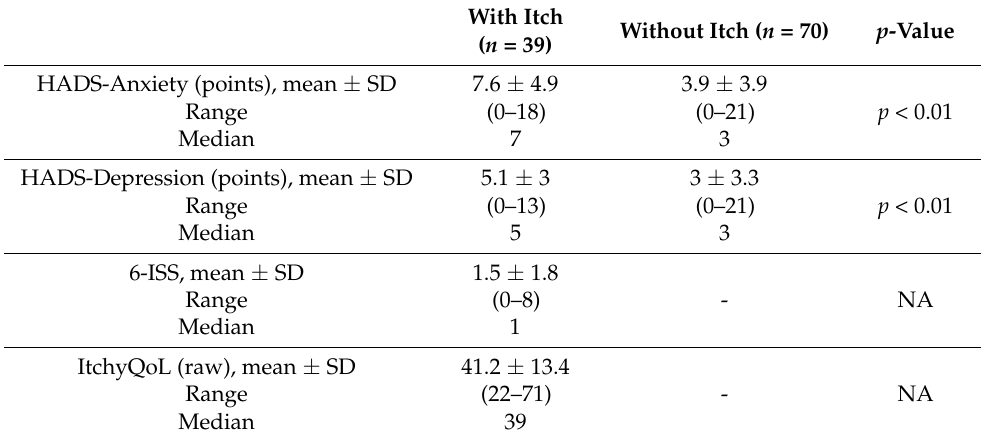
Table 4. Questionnaires’ scores and dependencies on selected clinical data.